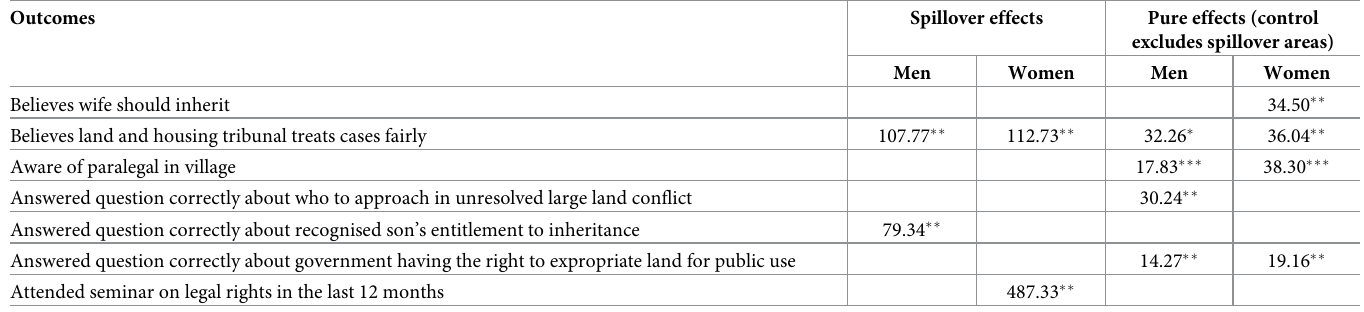
Table 13. CGLAS: Results of cost-effectiveness analysis accounting for